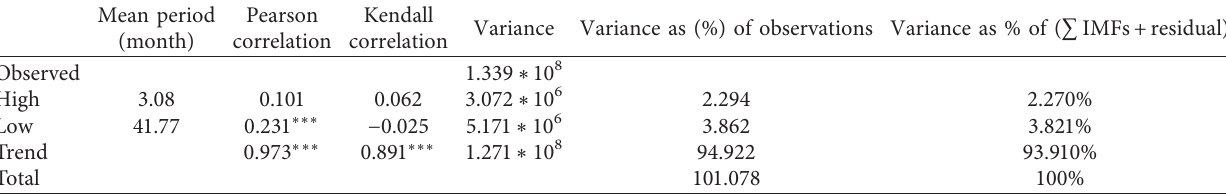
Table 5: Measures of three composed components of house prices.